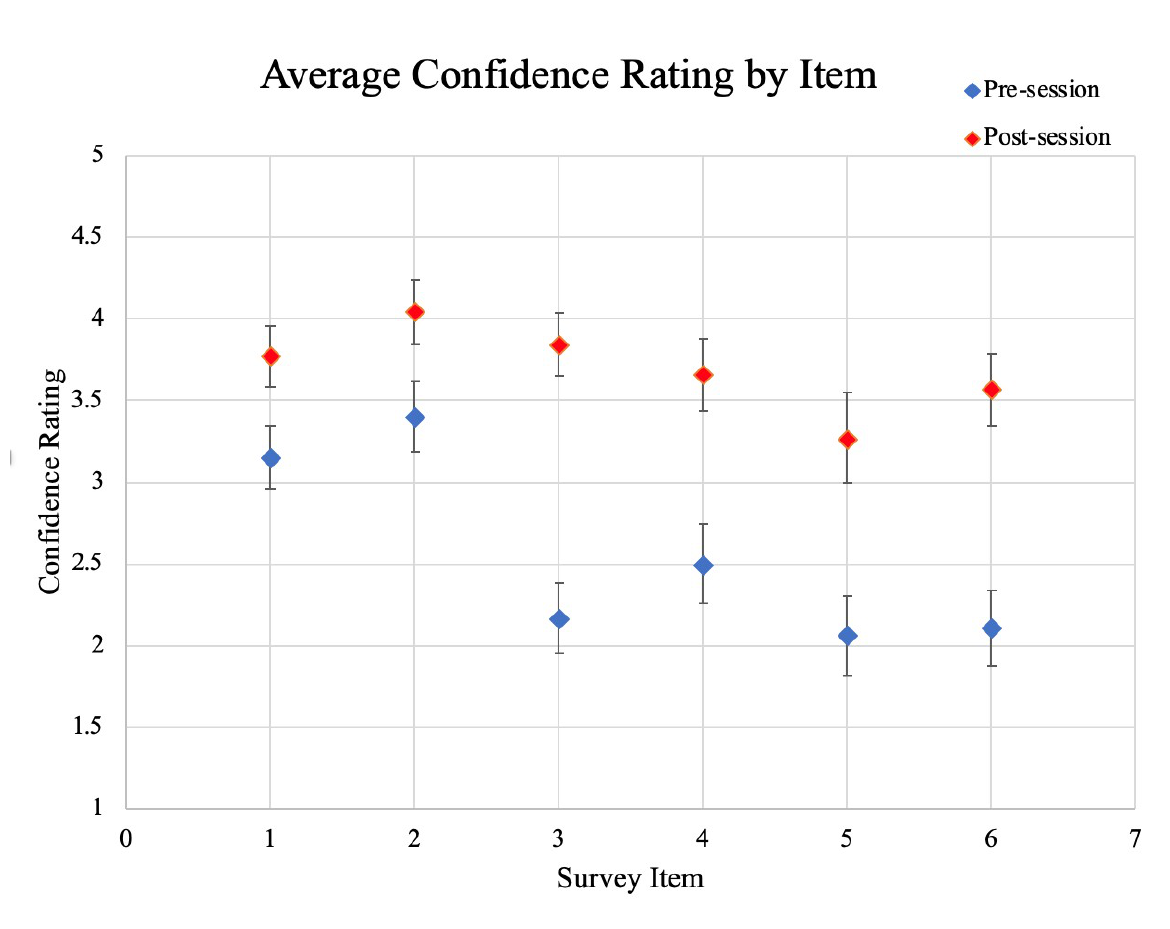
Fig 1. Chart represents mean confidence ranking for each survey item before and after the presentation. Error bars represent the 95% confidence interval. N=64 for pre-session responses and N=44 for post-session responses.